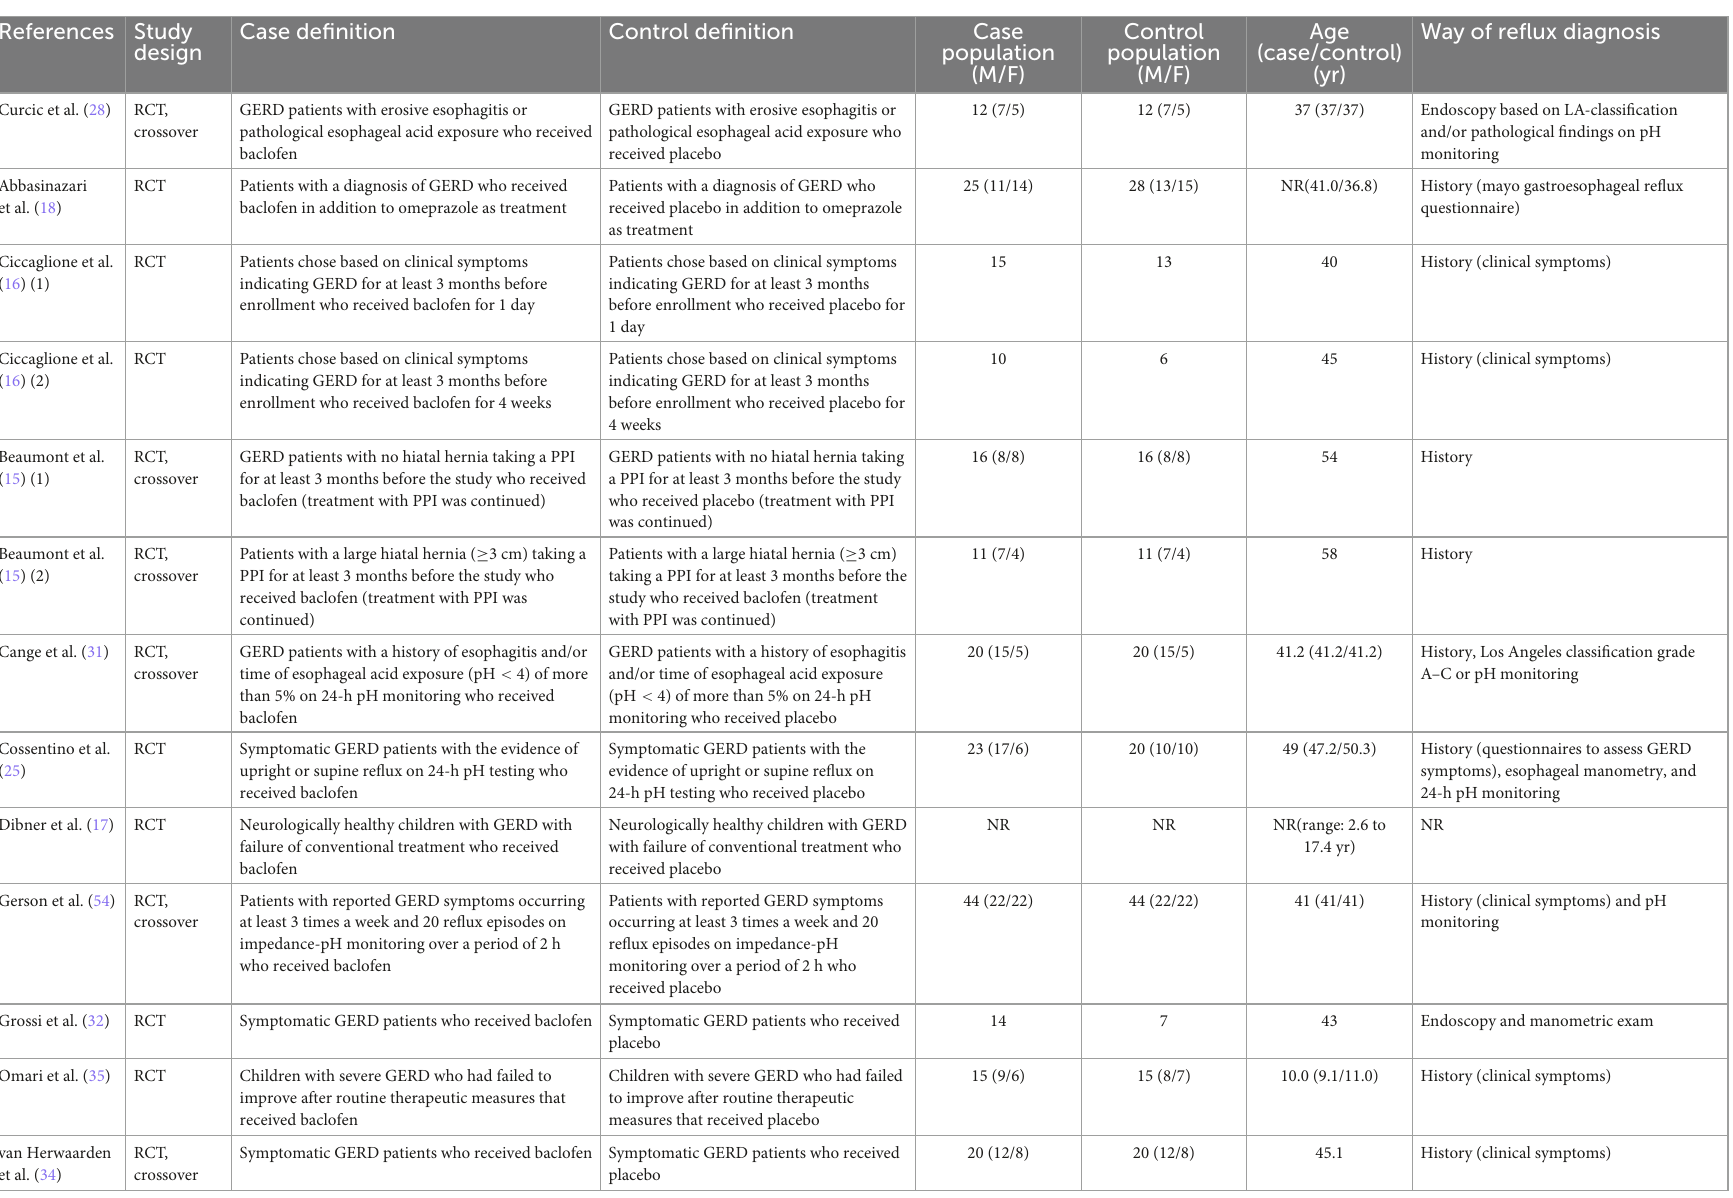
TABLE 2 Patients